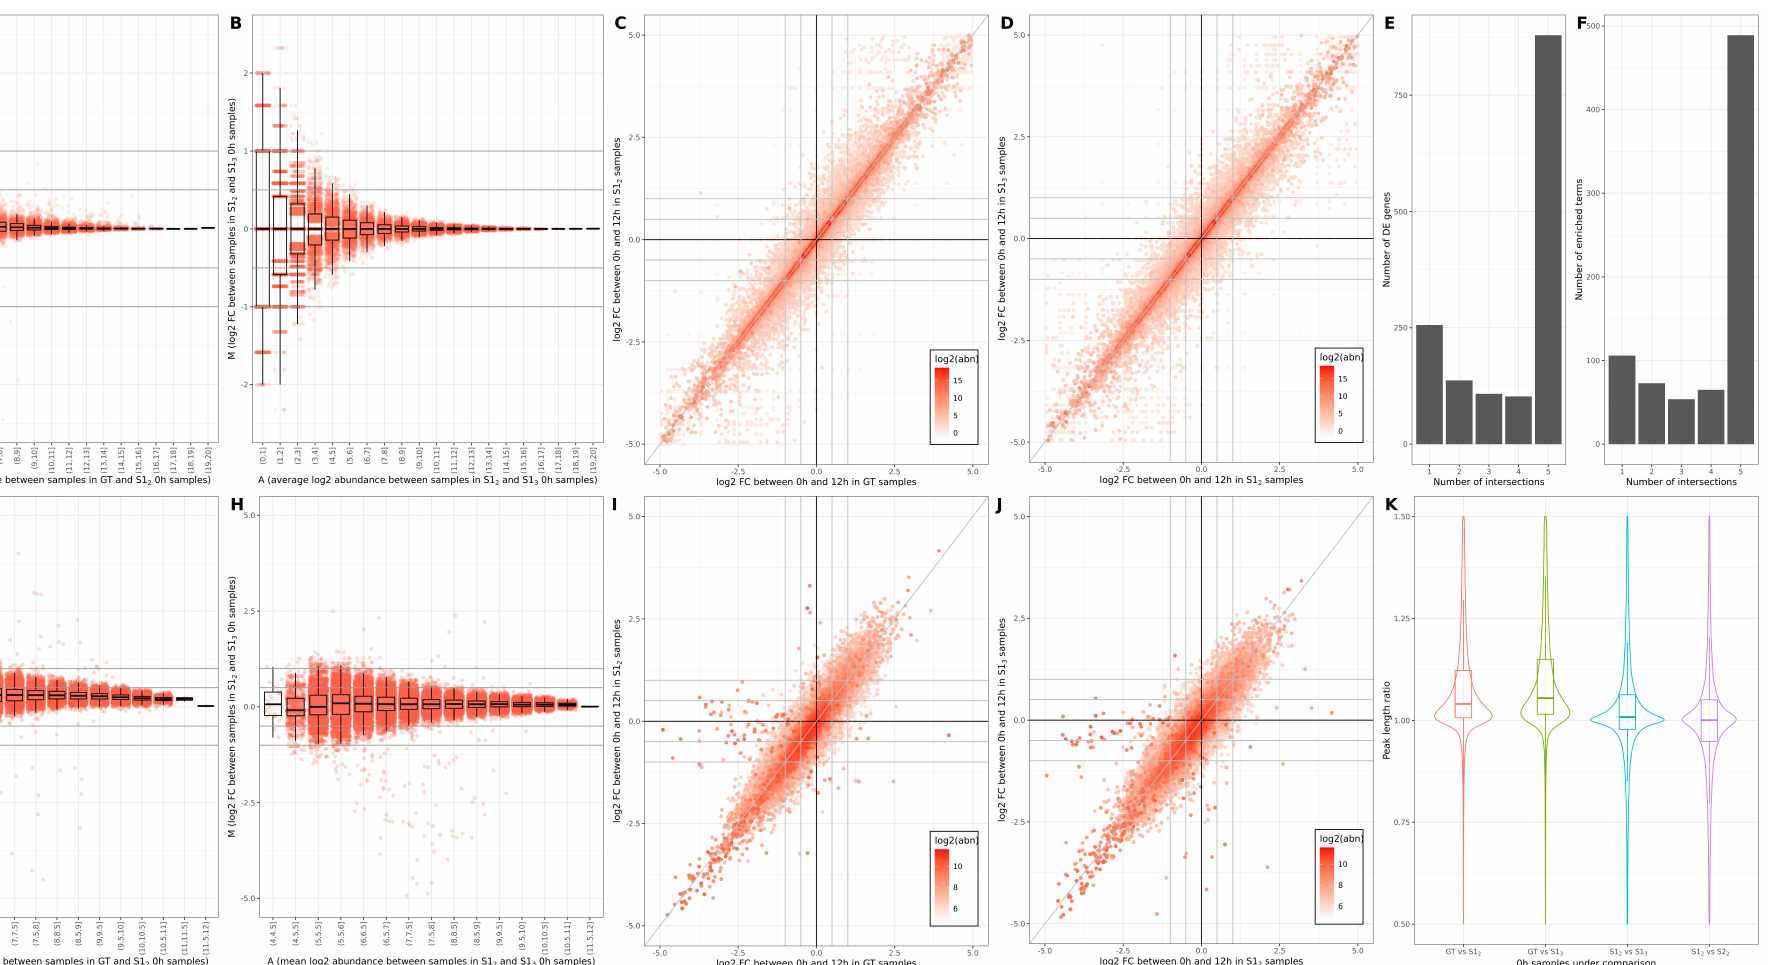
Figure 1. Comparison of bulk mRNAseq analysis results for GT and S samples . ( A , B ). Scatter (MA) and box plot summary on GT sample (0 h, rep1) and a corresponding k = 2 S sample S1 2 (subplot A) and k = 2 and k = 3 S samples S1 2 and S1 3 (subplot B). ( C , D ). Scatter (cross) plots comparing the DE amplitude (log